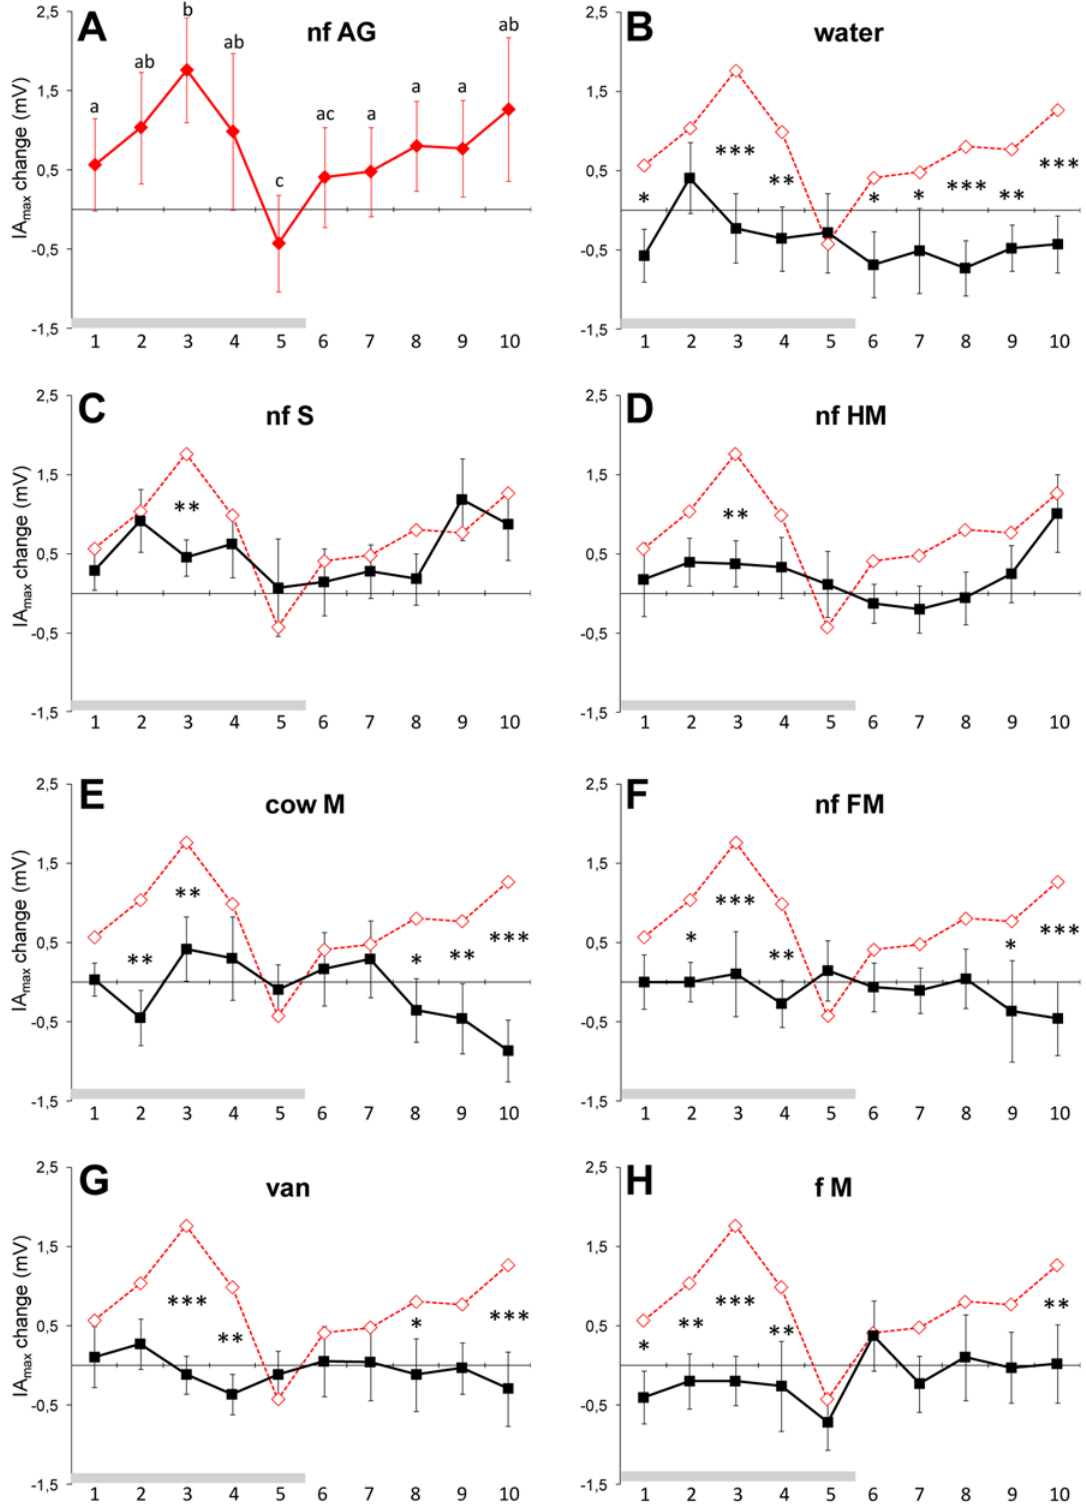
Figure 2. Inspiratory responses to areolar odor and to seven reference stimuli. Mean ( 6 sem) of maximum change of inspiratory amplitude (IA max ) in newborns during (2-sec stimulus blocks 1–5) and after (2-sec post-stimulus blocks 6–10) binarinal presentation of the following stimuli: A) areolar secretion; B) blank (water); C) sebum; D) human milk; E) cow milk; F) formula milk; G) vanillin; and H) habitual milk (mother’s milk in breast-fed and formula milk in bottle-fed infants). Key to abbreviations in legend of Figure 1; values of IA max in response to AG odor that differ significantly from the baseline are indicated by different letters; comparisons between the different stimuli (bold curves) and AG odor (red curves) are indicated by *, ** and ***: p , .05, .01 and .005, respectively; n=16).